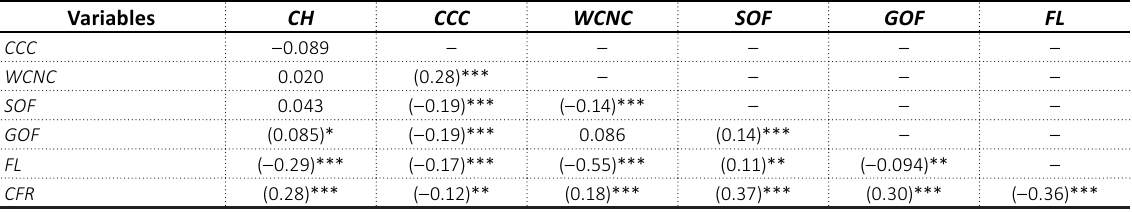
Table 4. Correlation